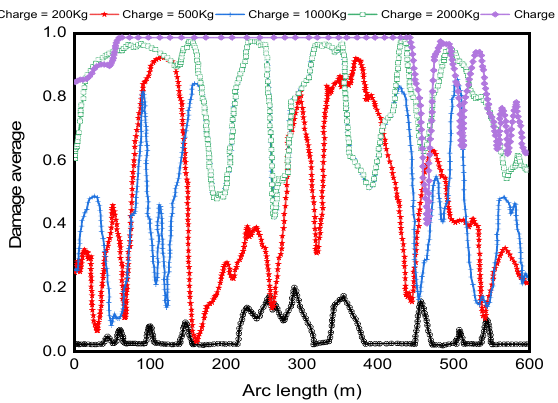
weight is 500 kg and 1000 kg. The dam crest damage curve reflects the main dam crest damage location characteristics and has a symmetrical distribution with the bang point as the center. This feature also reflects the mode-shaped participation characteristics that may exist at the arch dam crest under blasting load.